Question: Identify the chart type used in this figure.
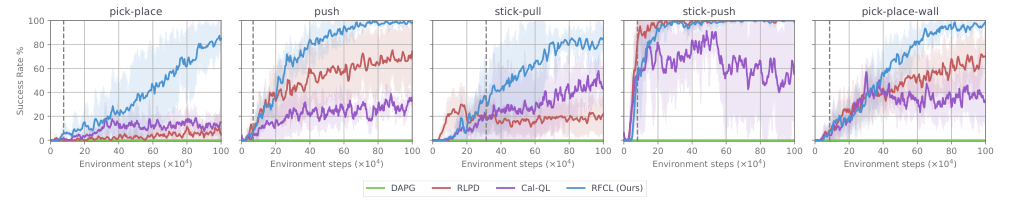
Answer: line